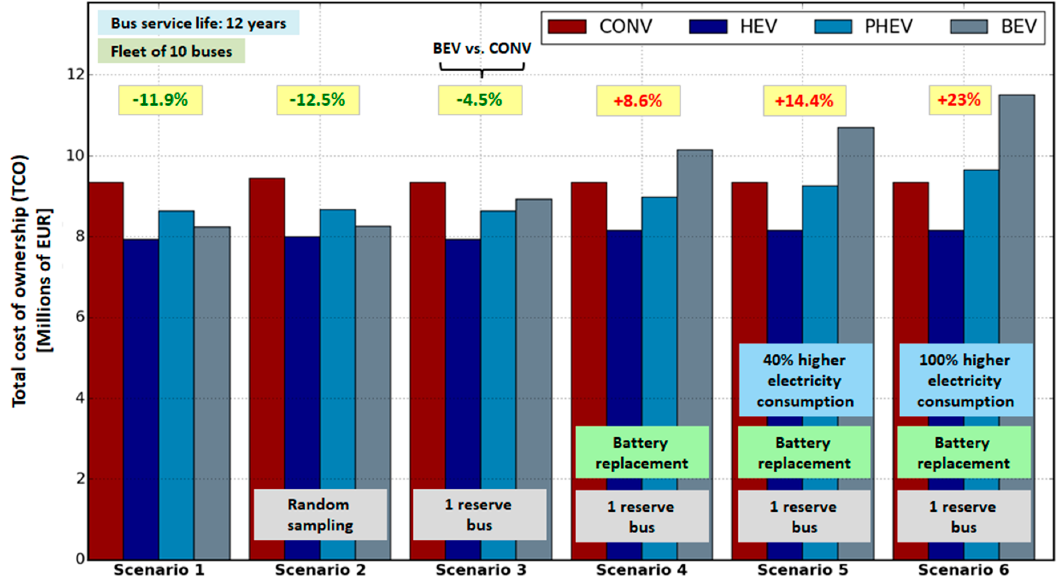
Figure 18. Comparative TCO values for different bus fleet types and electrification scenarios.